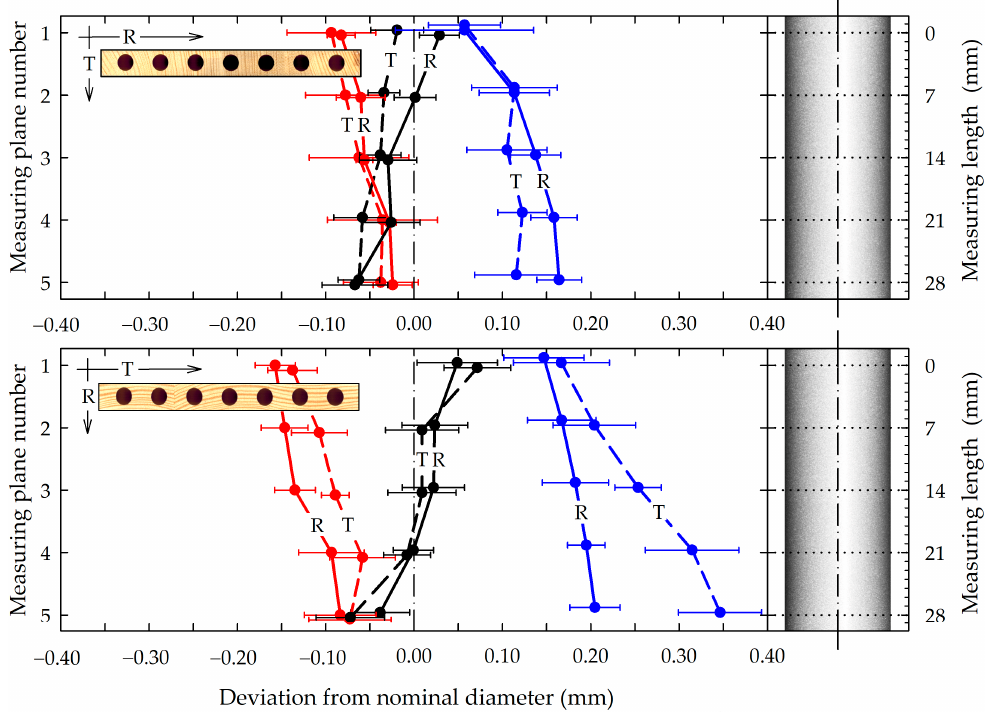
Figure 7. Deviation from a nominal diameter of drilled holes according to grain pattern and MC of radial ( above ) and tangential ( bottom ) samples; notations: black lines–conditions corresponding to RH = 60% (reference); blue lines—conditions causing swelling of samples (increased air RH to 85%); red lines—conditions causing shrinking of samples (decreased air RH to 35%); dots represent average ± standard deviation ( n = 7); R—radial anatomical direction; T—tangential anatomical direction.